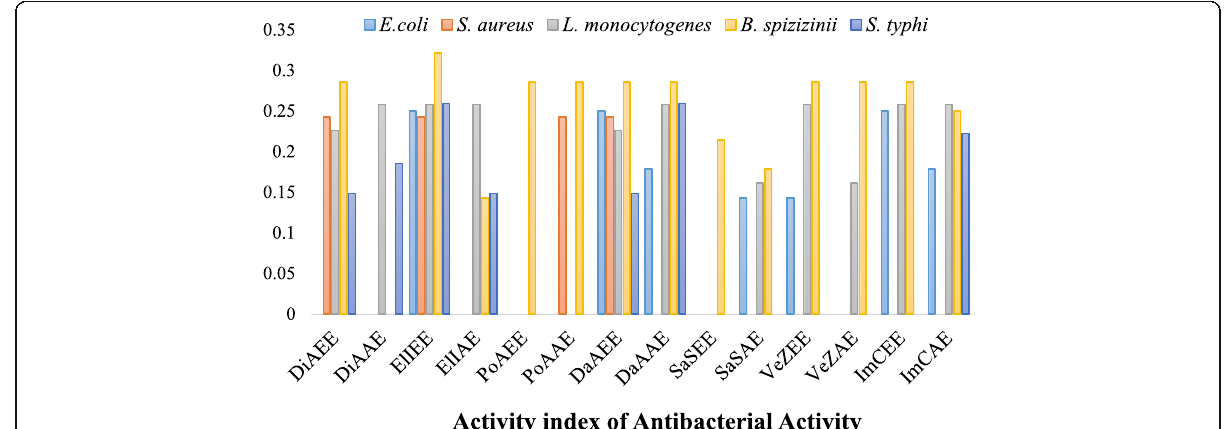
Fig. 6 Activity Index of antibacterial activity of selected ethanol and acetone plant